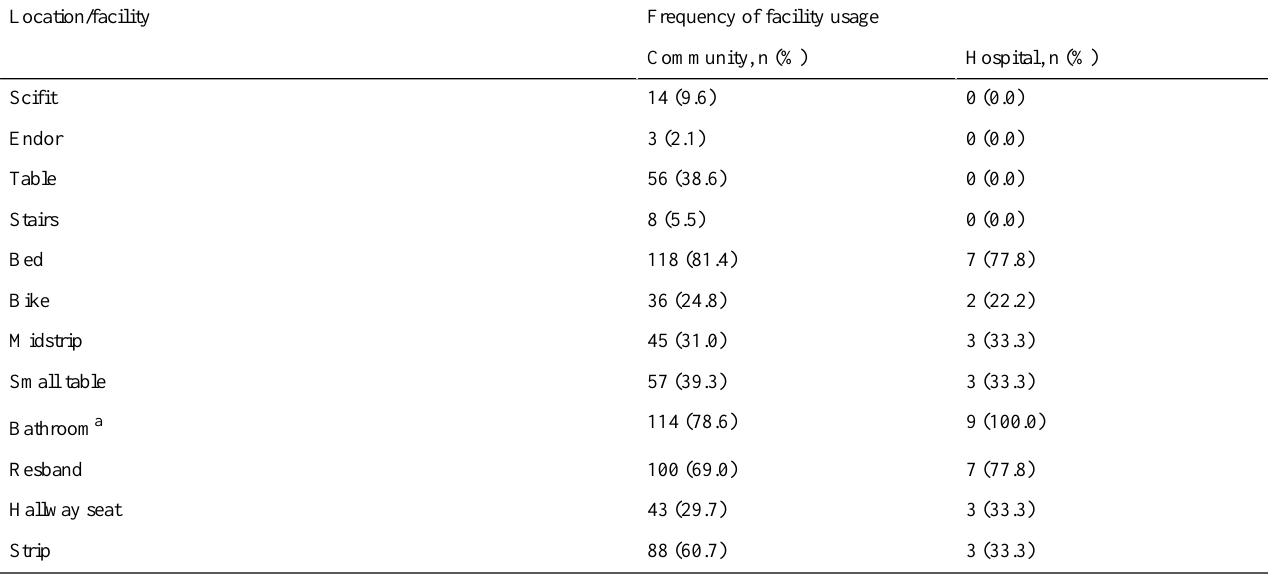
Table 6. Frequency of therapy room location/facility usage by